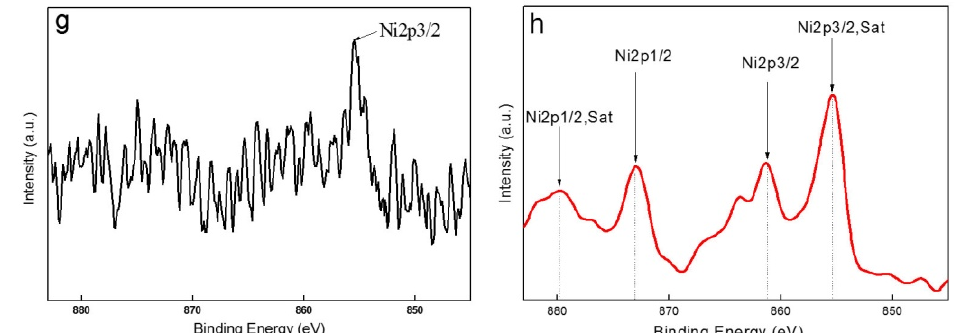
Figure 4. X ‐ ray photoelectron spectroscope (XPS) survey spectra ( a , b ) and high ‐ resolution XPS Figure 4. X-ray photoelectron spectroscope (XPS) survey spectra ( a , b ) and high-resolution XPS spectra spectra of O 1s ( c , d ), Ti 2p ( e , f ), and Ni 2p ( g , h ) of the 3 wt.% Ni ‐ doped TiO 2 nanofibers and 6 wt.% of O 1s ( c , d ), Ti 2p ( e , f ), and Ni 2p ( g , h ) of the 3 wt.% Ni-doped TiO 2 nanofibers and 6 wt.% Ni-doped Ni ‐ doped TiO 2 nanofibers. TiO 2 nanofibers.